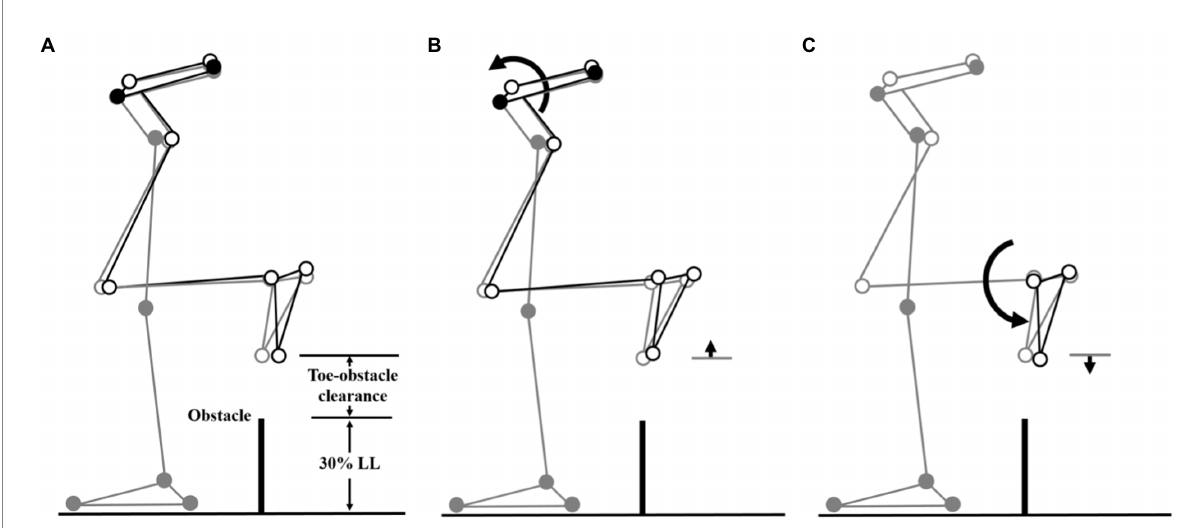
FIGURE 4 Effects of the observed significant angular changes at individual joints on the trailing toe-obstacle clearance in the MCI group (black stick figure) compared to Control ( A , grey stick figure) when the trailing toe was above an obstacle of 30% LL in height. The stick model was drawn using marker positions of a typical subject from each group. The segments with solid grey circles are joints of the reference limb. With the stance foot fixed to the ground, only one joint was rotated at a time according to the mean angular change reported in Tables 3, 5, while keeping the angles of the other joints fixed, and the segments of the stance limb and the segments of the swing limb distal to the current joint stationary. The MCI group showed decreased pelvic posterior tilt (B) and decreased ankle dorsiflexion in the swing limb (C) . As indicated by the black stick figure, (B) tended to increase the toe-obstacle clearance while (C) gave the opposite effect, leading to the observed normal trailing toe-obstacle clearance. Note that the stick figures were drawn based on the statistical results of the averaged values of both limbs reported in Tables 3,